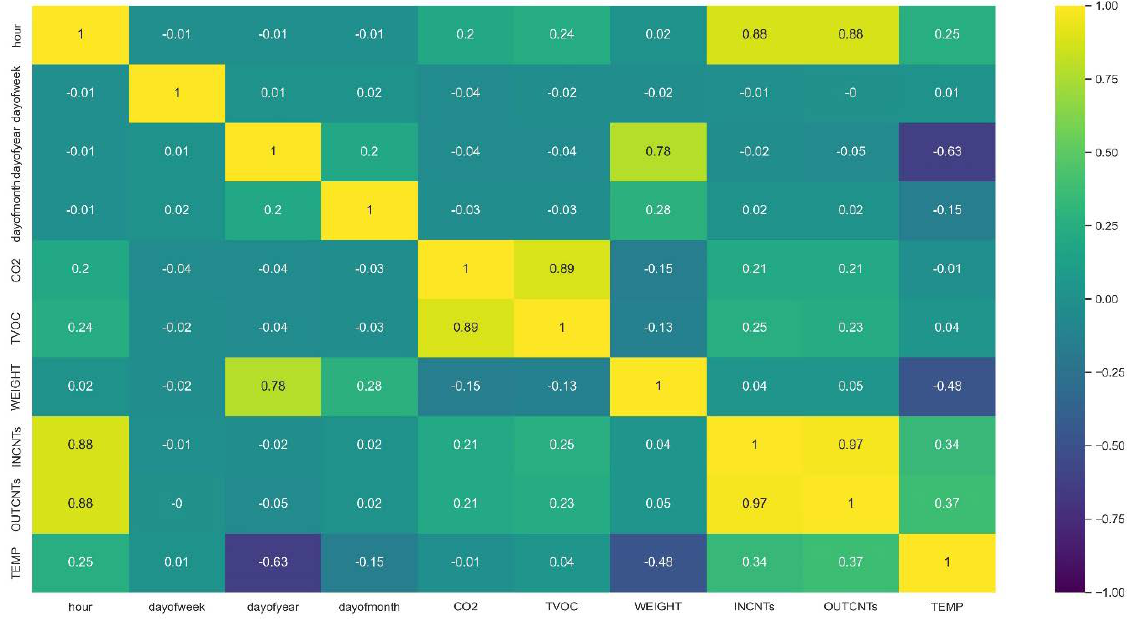
Figure 18. Correlation of features. The hour feature affects CO 2 , TVOC, TEMP and strongly the bee traffic in the entrance. The day_of_the_year variable affects weight. CO 2 and TVOC are highly correlated and in and out bee counts as well.